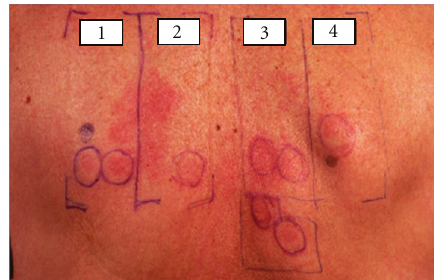
Figure 3: Positive skin reactions in the case illustrated include Row 1: cobalt chloride and balsam of peru, Row 2: nickel sulphate, Row 3: menthol, methyl methacrylate, palladium chloride, amalgam, and Row 4: ammoniated